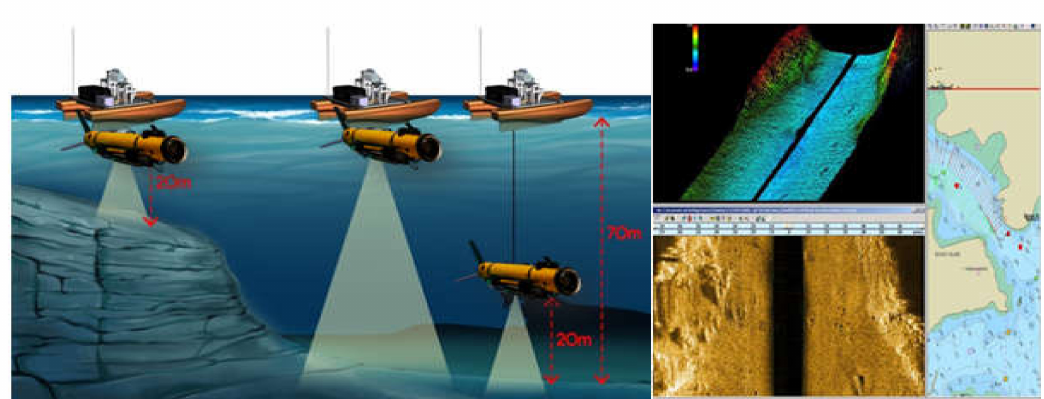
Figure 1. Operating concept and expected results of the integrated platform developed in this